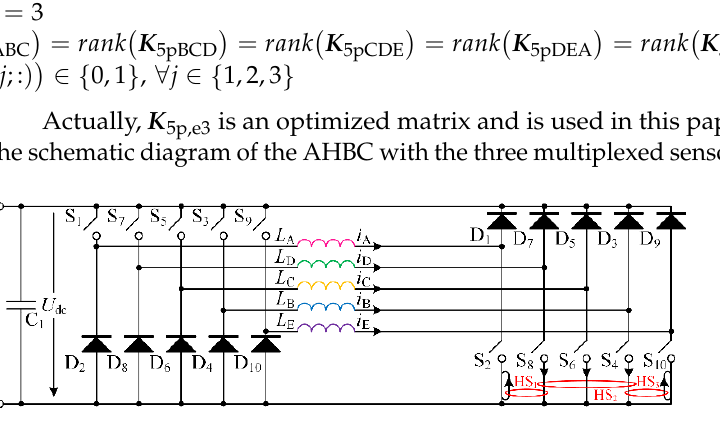
Figure 8. AHBC with three multiplexed current sensors for a five-phase SRM. be calculated when the corresponding lower switches are turned on.